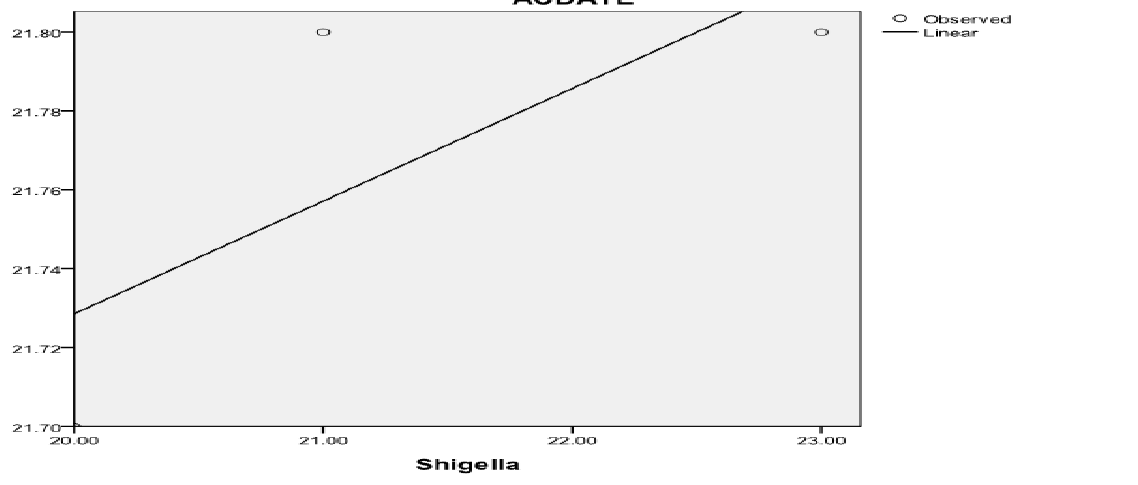
Figure 8. Correlation between treated AC of mango seeds and